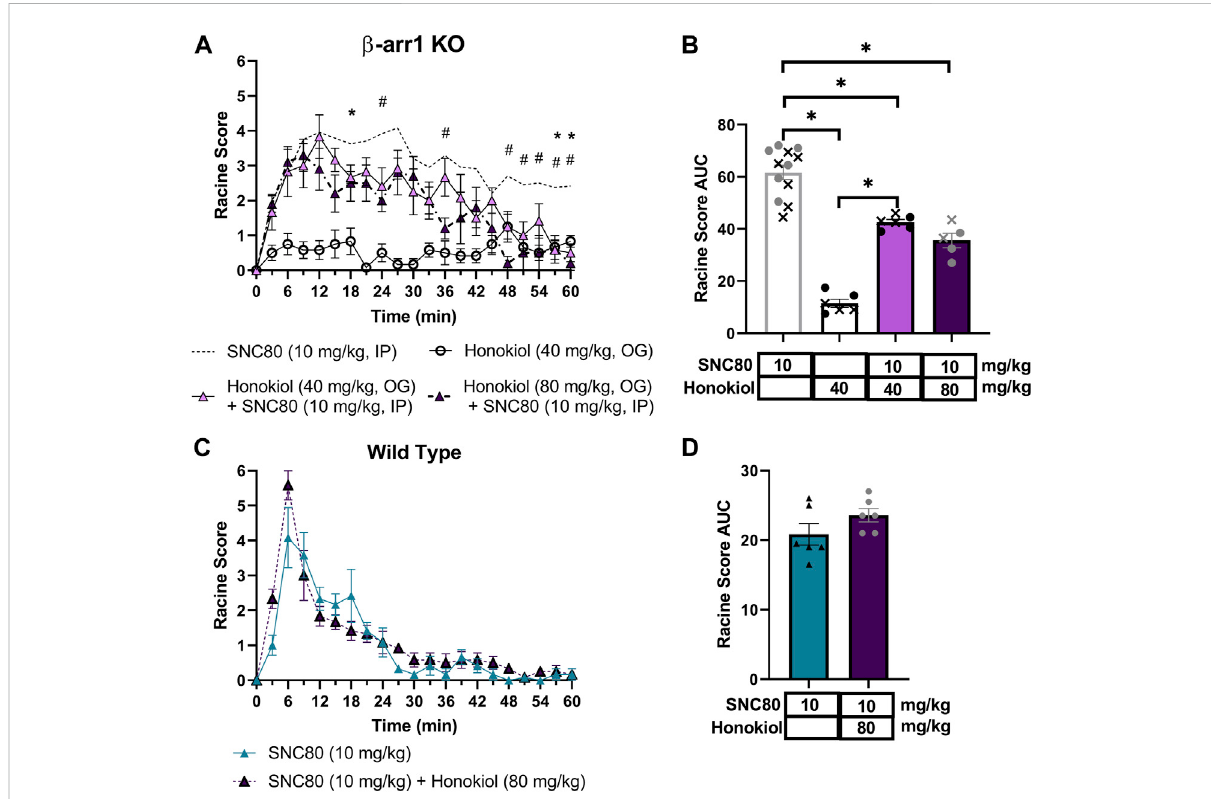
FIGURE 5 Honokiol dose-dependently reduces SNC80-induced seizures in β -arrestin 1 KO mice, but not in wild-type mice, and its seizure activity is attenuated by honokiol. Seizure activity over time (A) and as area under the curve (AUC) (B) in β -arrestin 1 KO or wild-type (C,D) mice exposed to SNC80(10mg/kg,i.p.),honokiol(40mg/kgp.o.)orSNC80+40or80mg/kghonokiol.[n=5(3femaleand2male)for β -arrestin1KOmiceandn=6 female per treatment for wild-type mice]. *p < 0.05. Dotted line depicts 10 mg/kg SNC80 in β -arrestin 1 KO (A) or wild-type mice (C) for reference. In (B) male mice are depicted with a cross, whereas female mice are depicted as solid